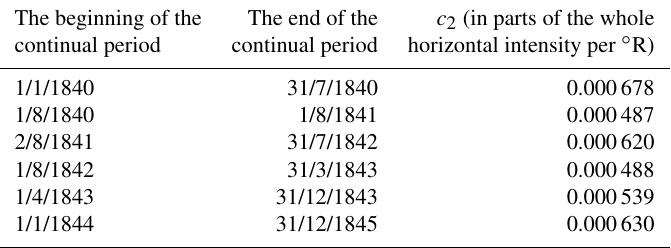
Table 3. The values of the temperature coefficient c 2 for six continuous periods from the beginning of 1840 to the end of 1845. The beginning of the The end of the c 2 (in parts of the whole continual period continual period horizontal intensity per ◦